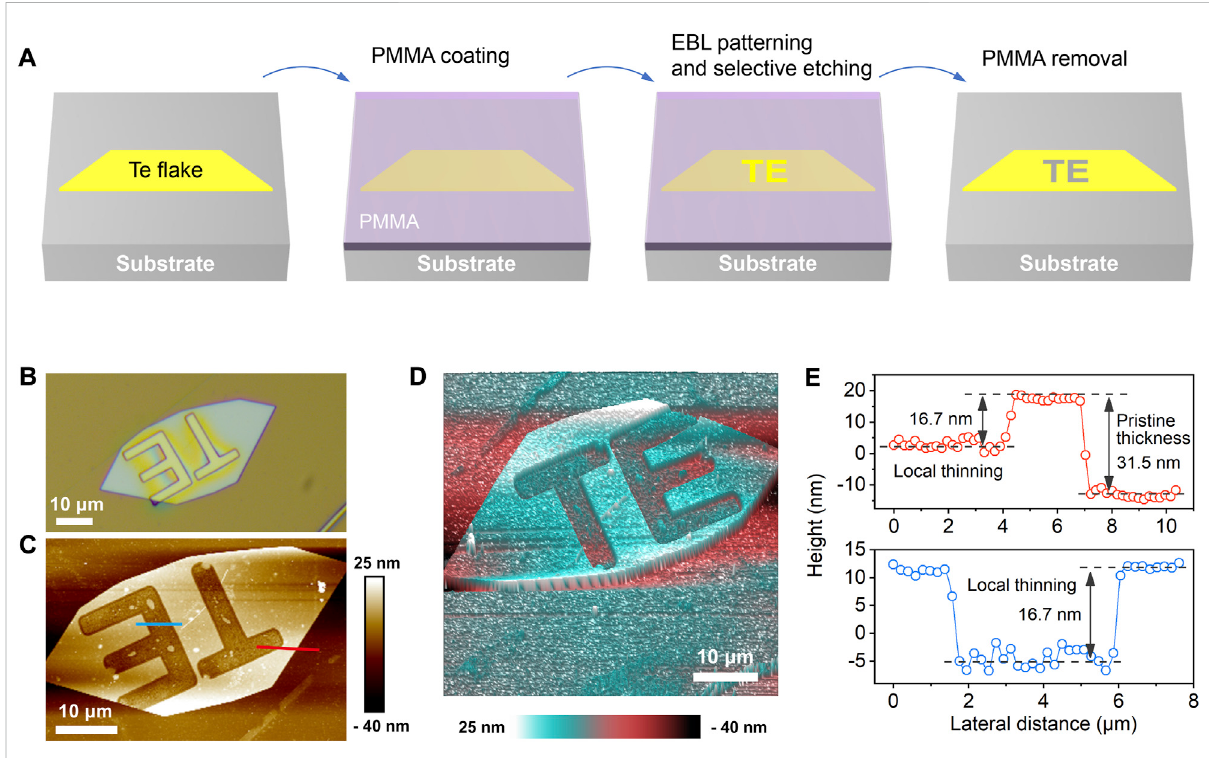
FIGURE 3 (A) Schematic fabrication process for the thickness patterning of Te nanosheet. (B) Optical image of the Te nanosheet with a “ TE ” photoresist pattern on the surface. (C – D) 2D and 3D AFM images of the locally-thinned Te fl ake. (E) Height pro fi les along the blue and red lines in (C) , revealing the capability of local thinning with this oxidative etching